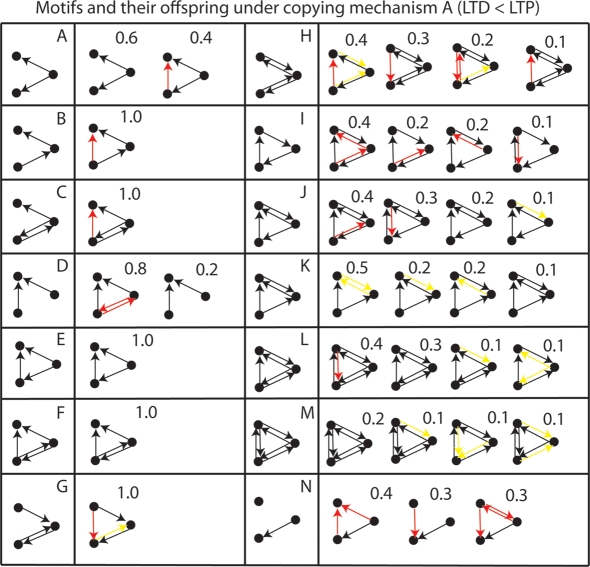
Motifs and the exploration distribution resulting from copying by mechanism A with modified LTD/LTP ratio.τ− = 10 ms. Red arrows show new connections and yellow arrows show lost connections. The proportion of copies of each type is displayed above the copy structure.